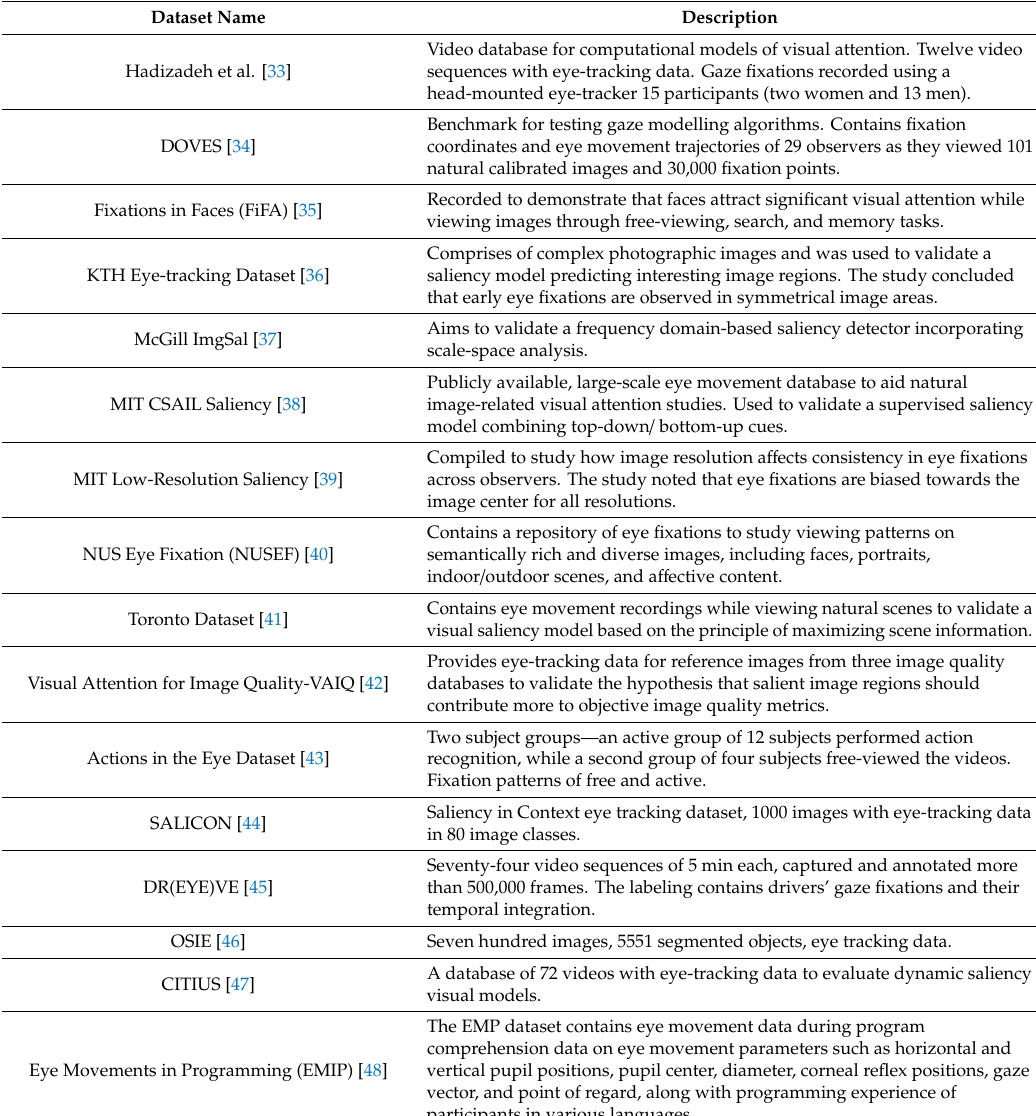
Table 2. Eye gaze datasets for saliency / cognitive